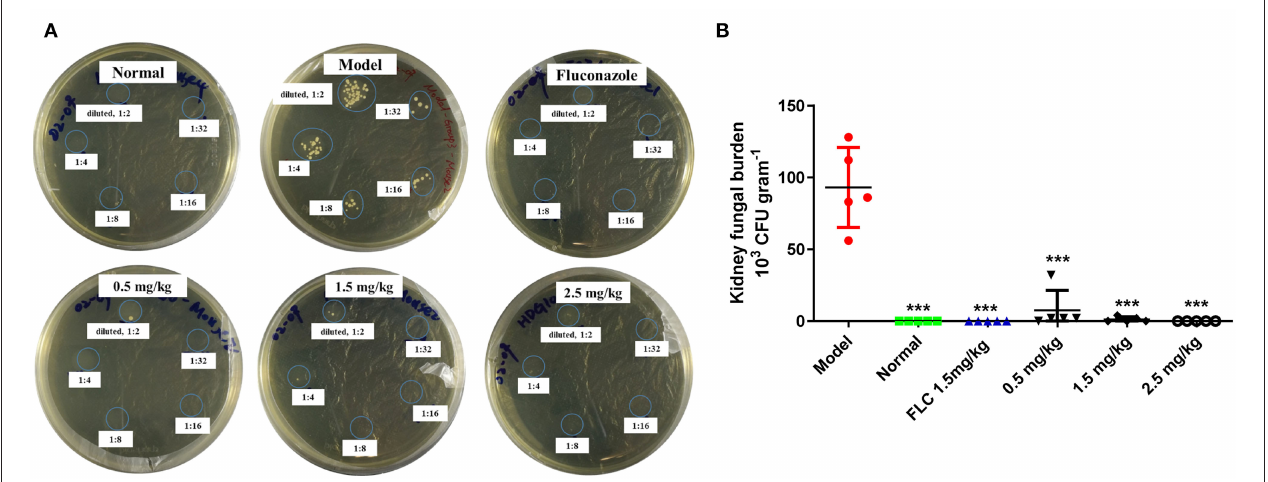
FIGURE 6 | Fungal burden in the kidneys. (A) C. albicans CFUs in the kidney tissue at killing are shown in panels for the representative mice in each group. (B) Fungal burdens per gram of the kidney ( n = 5 mice). Significance is represented with asterisks (*** p < 0.001). Normal: no inoculation of C. albicans , water-shamed; Model: infected with C. albicans , water-shamed; Fluconazole (1.5 mg/kg/d) and SAN (0.5, 1.5, and 2.5 mg/kg/d, respectively).